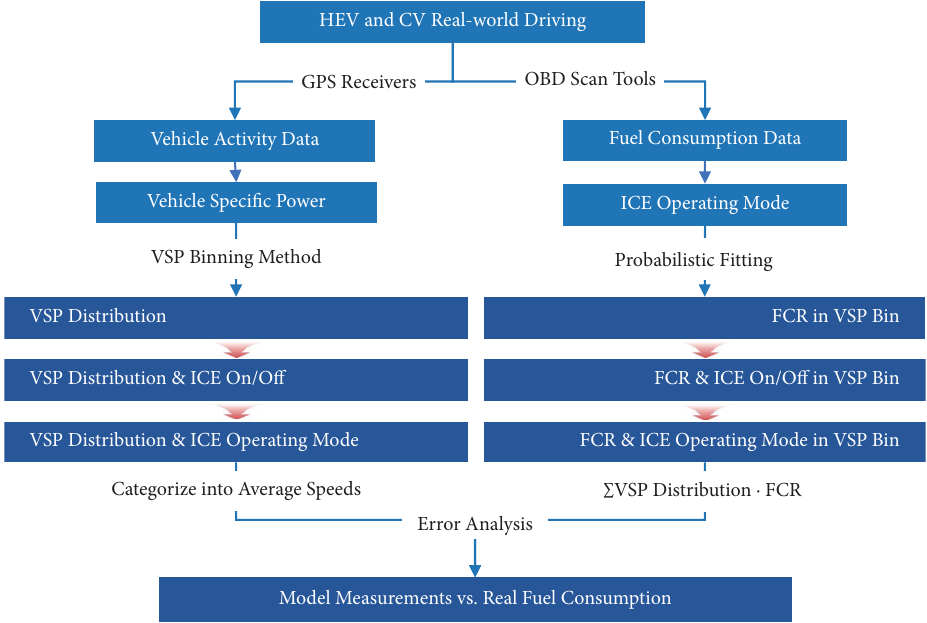
Figure 1: Framework of the